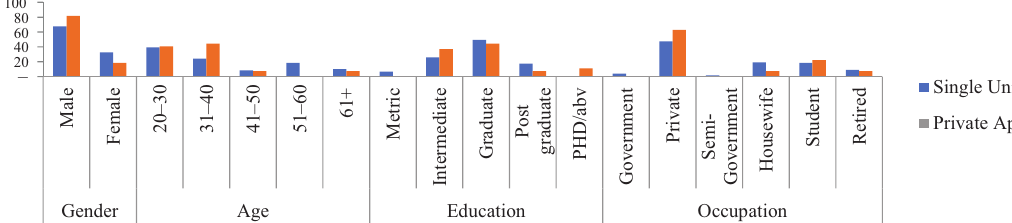
Figure 3. Respondent detail of the residents of single unit (S.U.) houses and apartments (source: field survey)